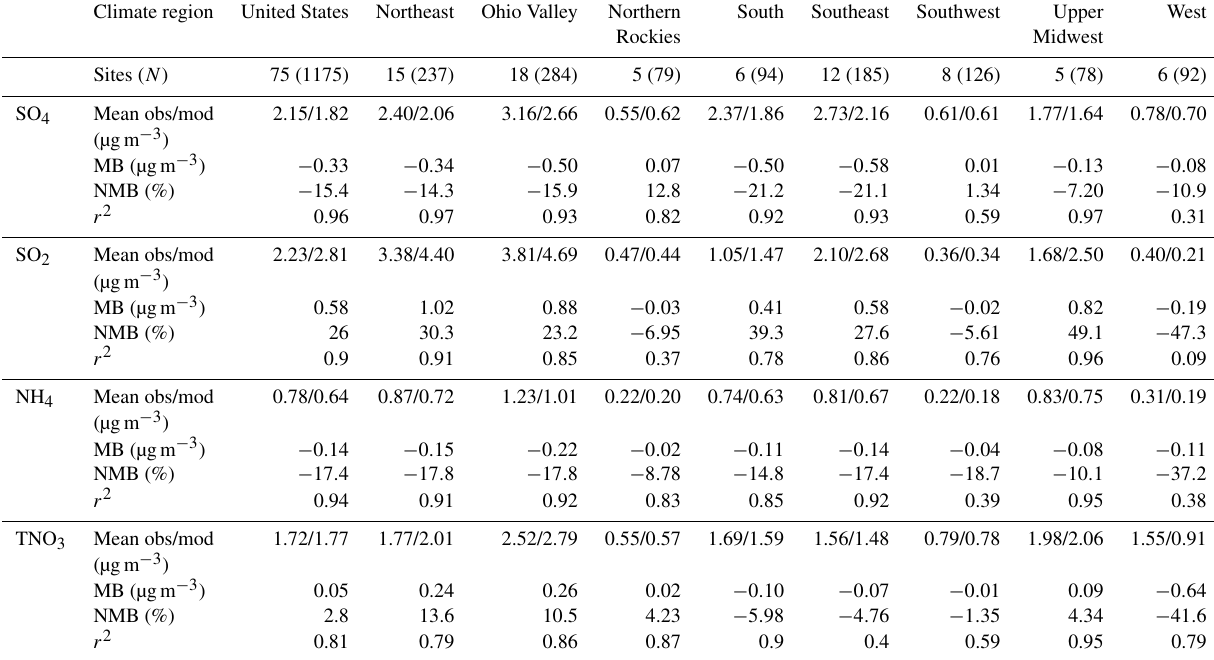
Table 3. Evaluation of EQUATES modeled average concentrations (µgm − 3 ) of SO 2 , SO 4 , TNO 3 , and NH 4 compared to CASTNET mea- surements in the CONUS and eight climate regions (no CASTNET data are available in the Northwest climate region; obs/mod: observed/-